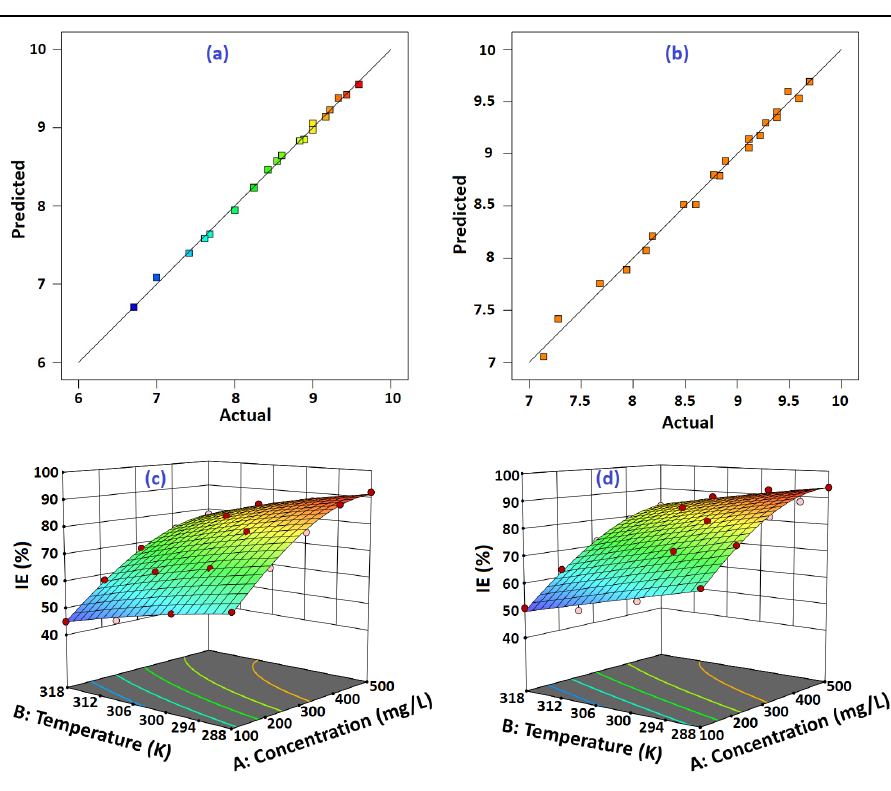
Figure 16. The correlation between the experimental and the predicted % IE values for: ( a ) Amy and ( b ) Raf; 3D surface plots of outcome % IE for: ( c ) Amygdalin (Amy), and ( d ) Raffinose (Raf). Three-dimensional surface plots were taken into consideration to anticipate the com- bined parameters that exhibited significant results on the corrosion inhibition process.